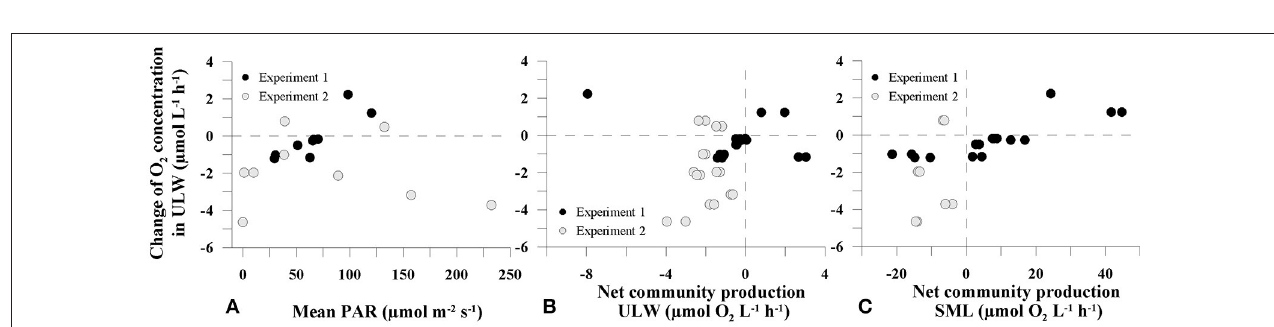
FIGURE 3 | Relationship between temporal changes of O 2 concentration in the underlying water (ULW) and mean photosynthetically active radiation (PAR) (A) , net community production (NCP) in ULW (B) and the sea-surface microlayer (SML) (C) .